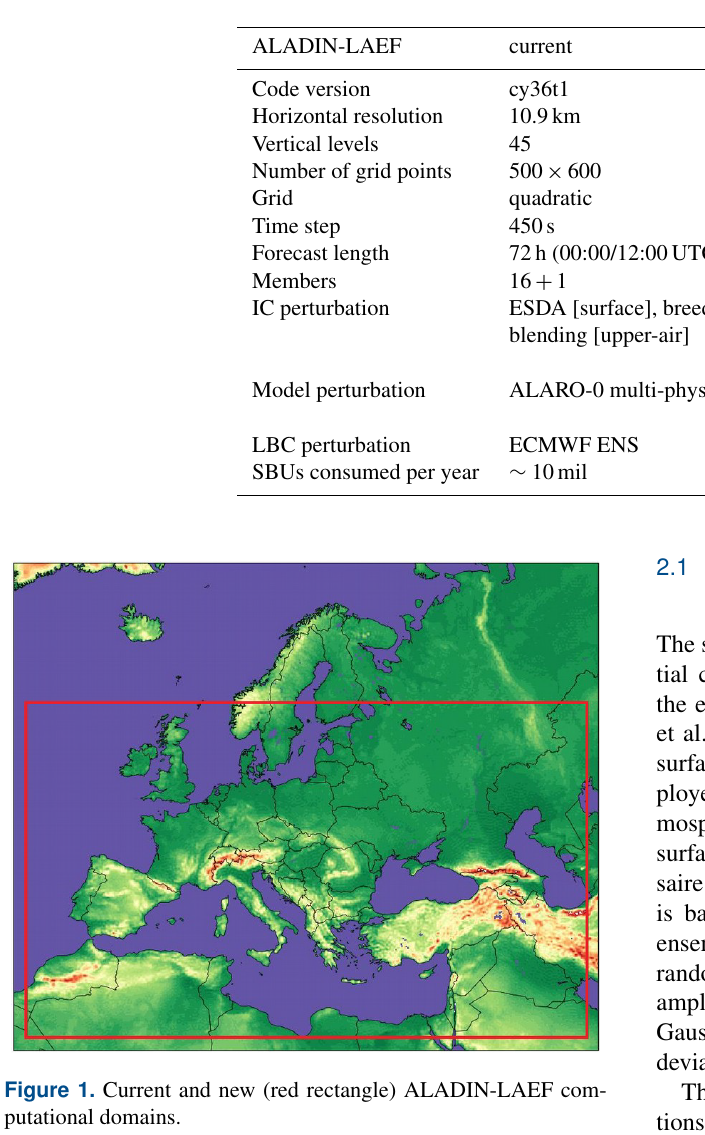
Table 1. ALADIN-LAEF system specifications for current and new version.